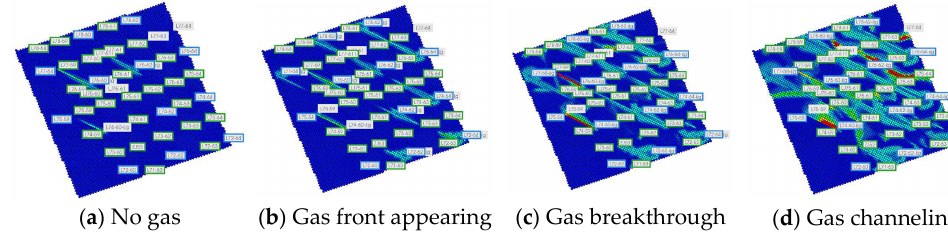
Figure 5. Comparison of dynamic production curves.